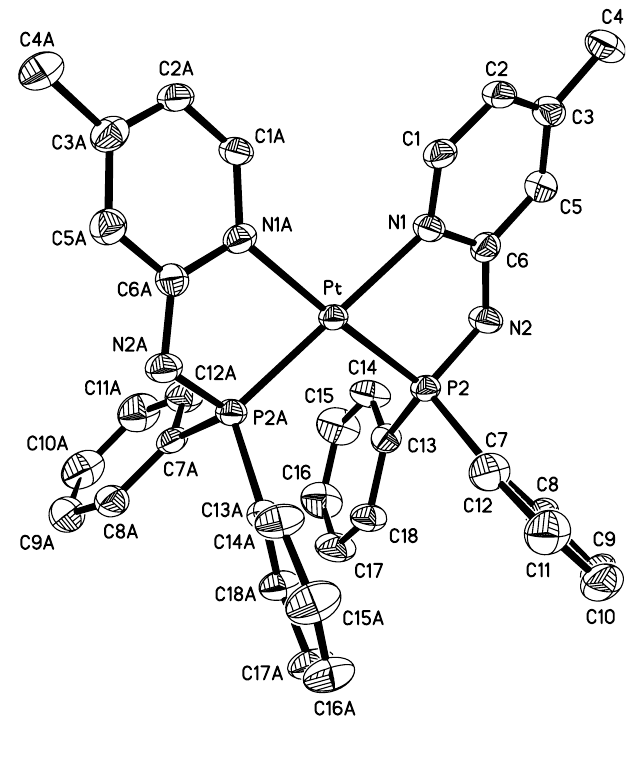
Table 2. A tomic coordin a tes a nd displ a cement p a r a meters (in Å 2 )